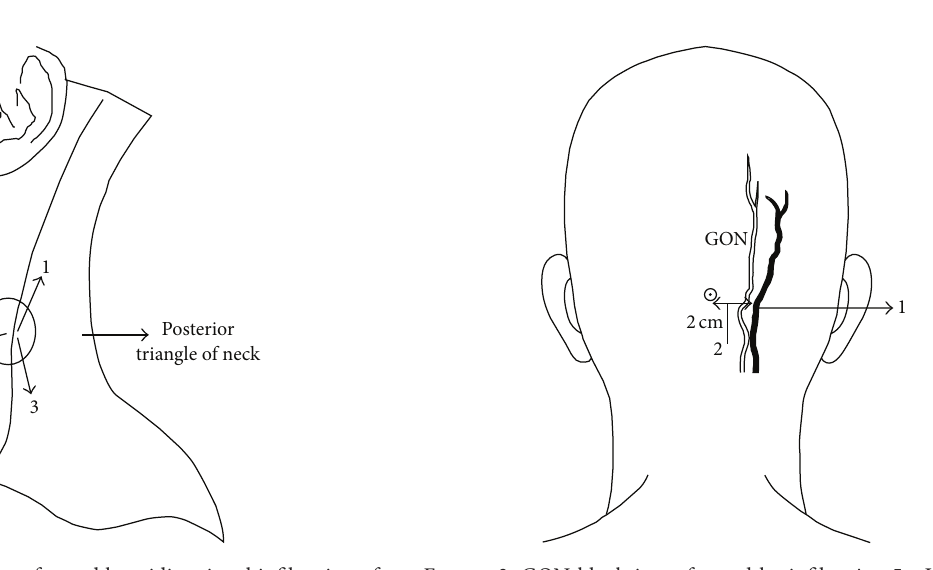
Figure 2: GON block is performed by infiltrating 5mL of 0.25% Bupivacainewithneedleinsertedmedialtotheoccipitalartery(1).In cases where the artery is not palpable, the needle can be inserted to a depth of approximately 1cm at a point 1cm below and 2 cm lateral to the midpoint of the greater occipital protuberance